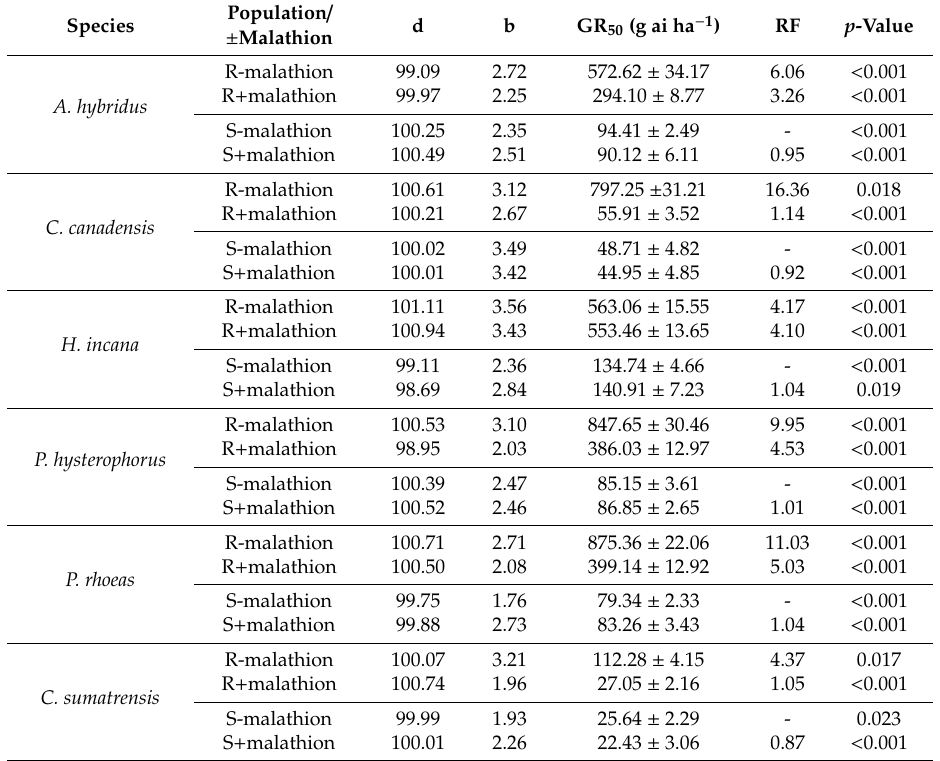
Table 2. Parameters of the log-logistic used to estimate the dose-response regression curves (% dry weight) in dicotyledonous weeds susceptible (S) and R to 2,4-D with ( + malathion) or without (-malathion) previous application of malathion at 2000 g ai ha − 1